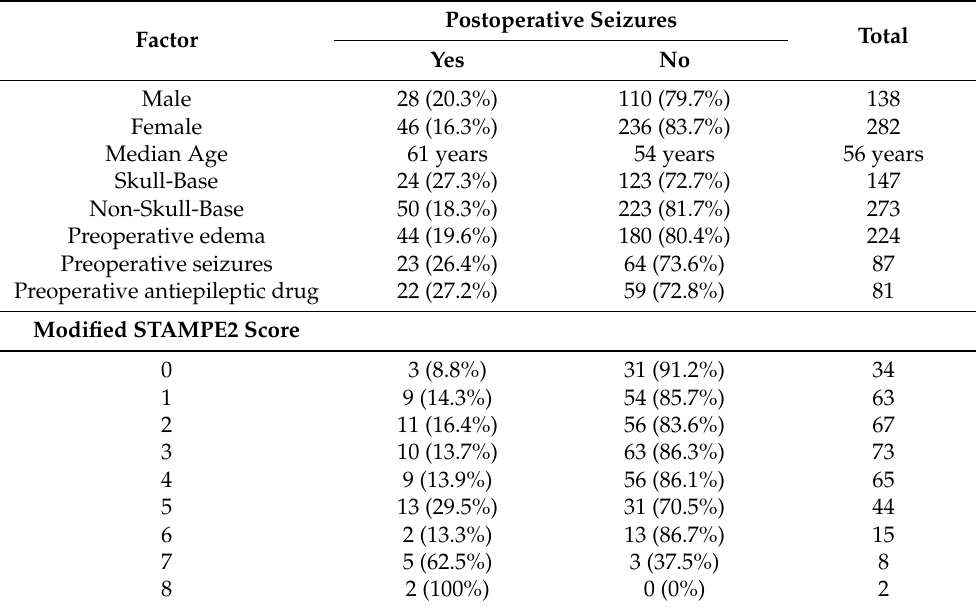
Table 2. Postoperative patient characteristics.